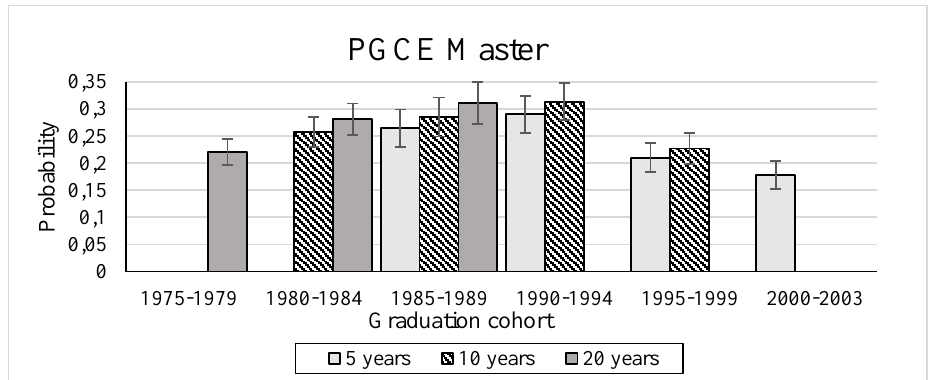
Figure 2. Predicted probability that master’s graduates with postgraduate teacher education (PGCE) are not employed in the school sector, by graduation cohort, at 5, 10, and 20 years after graduation. 95% CI error bars